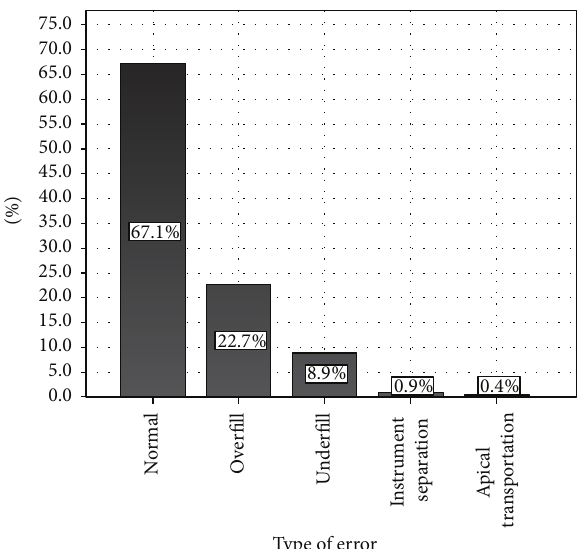
Figure 3: Distribution of procedural errors in all root canal treatment cases.